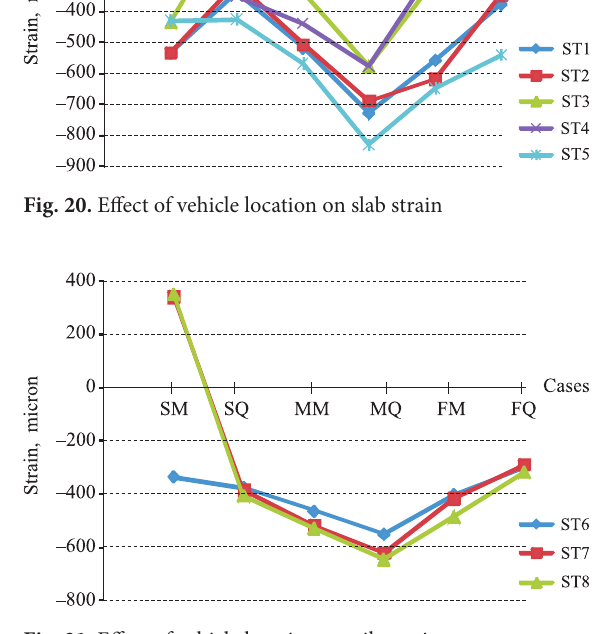
Fig. 21. Effect of vehicle location on pile strain